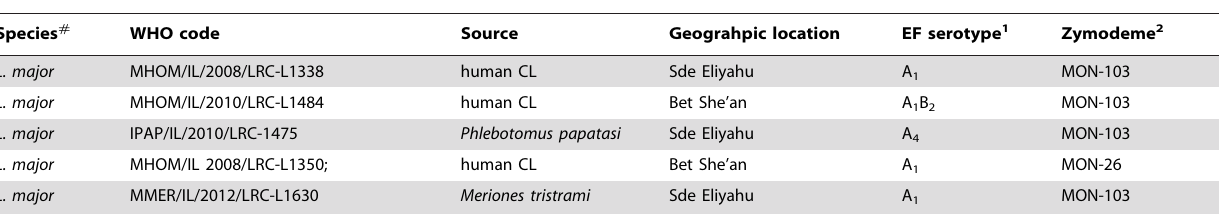
Table 3. Leishmania major isolates from Sde Eliyahu.